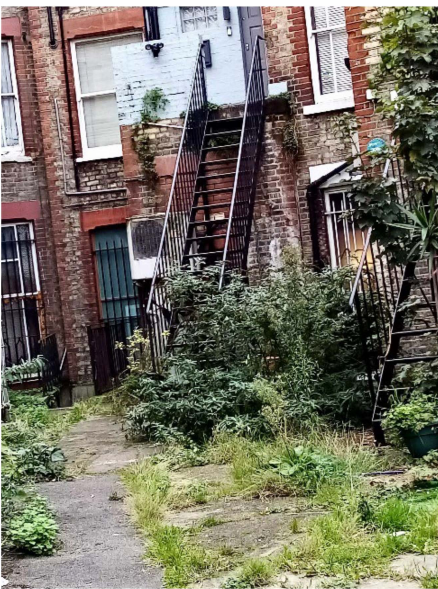
Figure 23. “The staircase leading into my